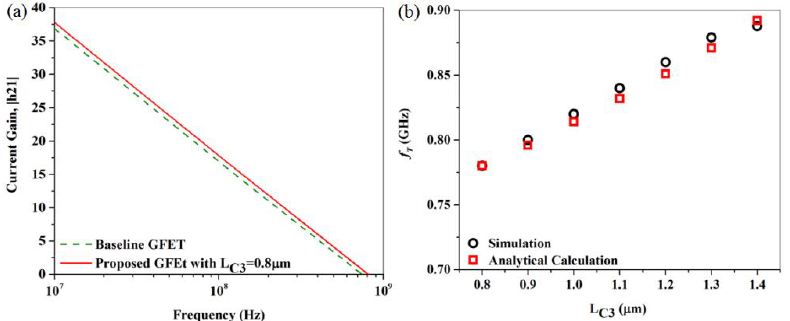
Figure 10. ( a ) Current Gain, |h21| of the baseline GFET-1 along with that of the proposed hybrid contact GFET in the electron regime (V gs = +2.0 V and V ds = +5.0 V) plotted with respect to frequency; ( b ) The current gain cut-off frequency ( f T ) of the proposed GFET extracted from |h21| vs. f characteristics, plotted with respect to L C3 .